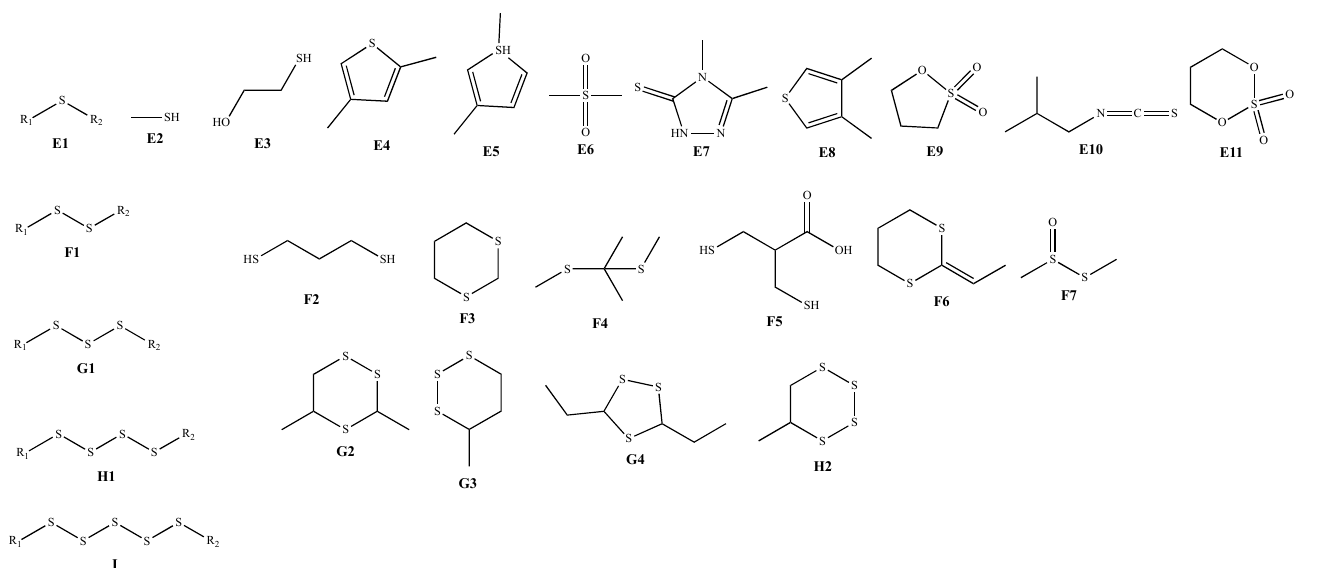
Figure 3. Structure of sulfur-containing compounds identi fi ed in AMB.